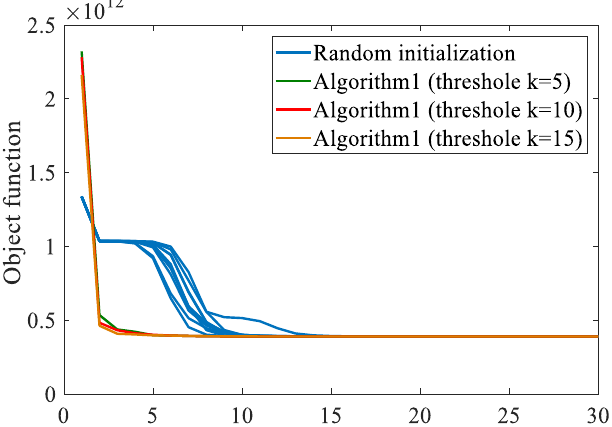
ff erent number of